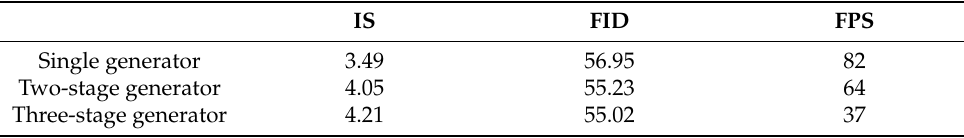
Table 6. Comparison of the effectiveness of the generator networks.